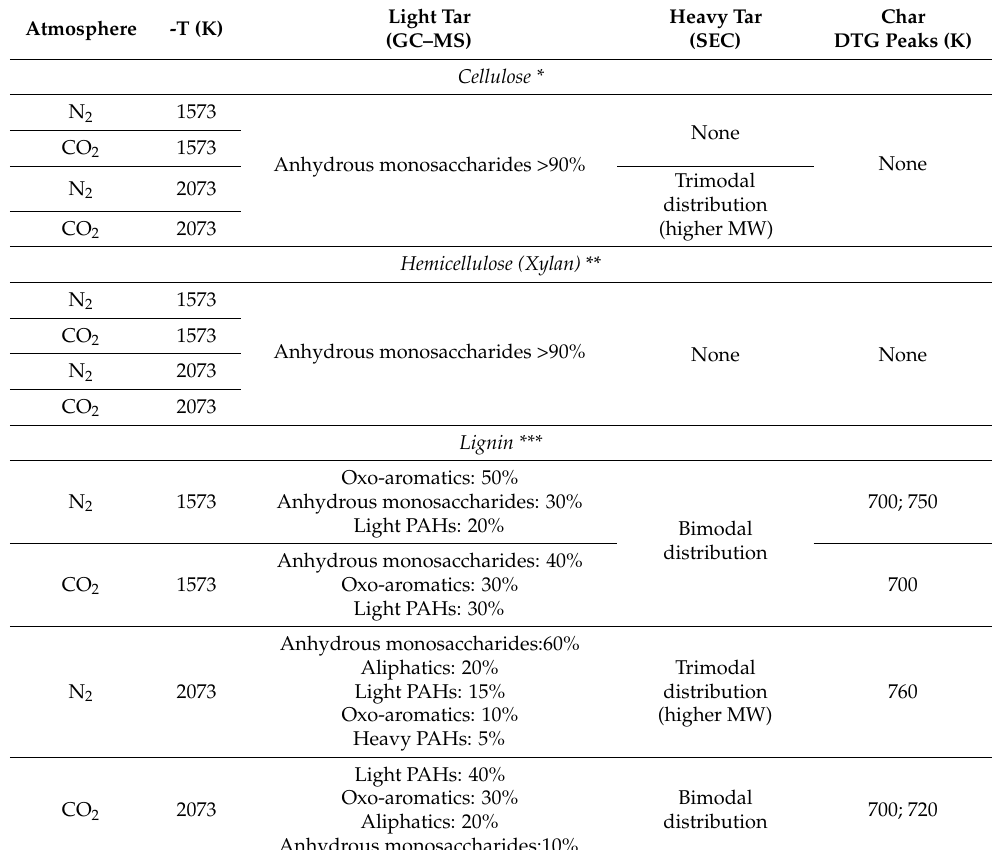
Table 4. Summary of results for single biomass components. Adapted with permission from Ref. [22] 2022,